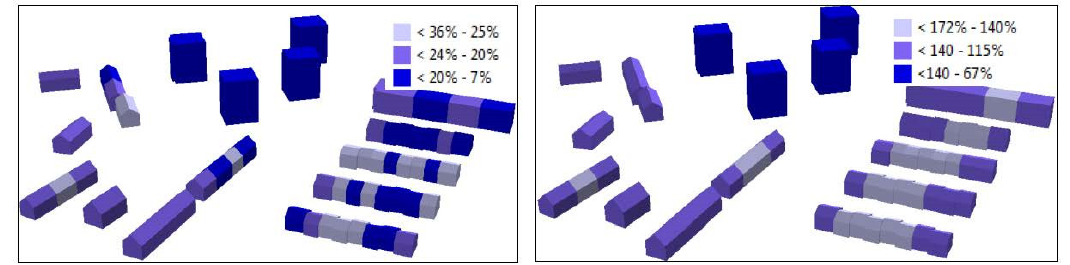
Figure 15. Increase of annual cooling energy needs in 2050 ( left ) and in 2100 ( right ), compared to the reference scenarios.